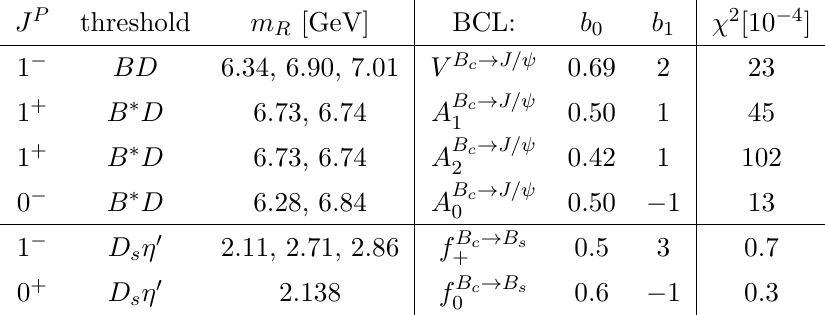
Table 8 . Summary of the (cid:12)ts for B c ! J= and B c ! B s form